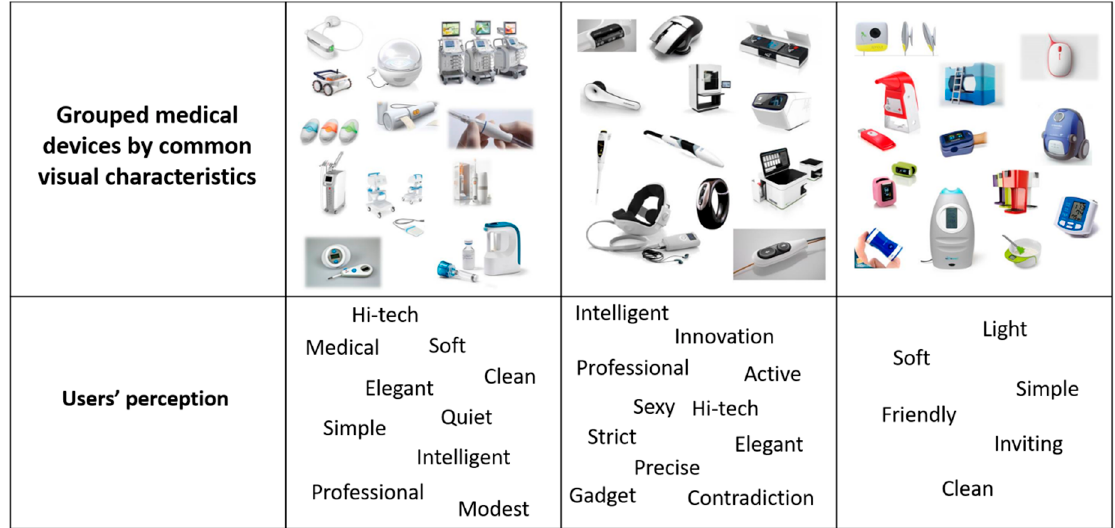
Figure 6. Medical device design inspiration boards and ascribed perception words.